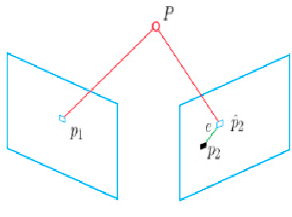
Figure 3. The re-projection error.